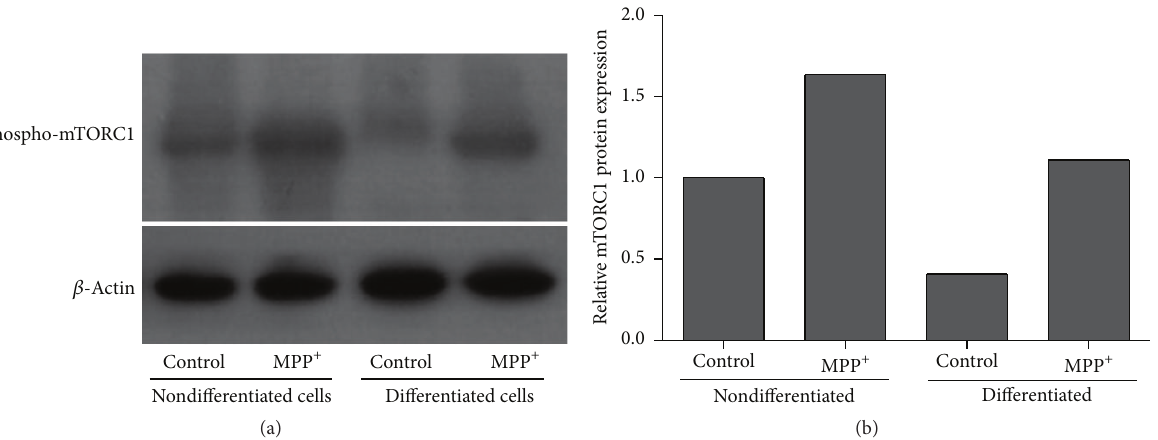
Figure 8: Relative protein expression of phospho-mTORC1 in nondifferentiated and differentiated SH-SY5Y cells by Western blot. For neuronal differentiation, SH-SY5Y cells were treated with 10 𝜇 M retinoic acid for three days before exposure to MPP + . The control groups for nondifferentiated and differentiated SH-SY5Y cells were treated with the same medium without MPP + . (b) represents the quantification of the band density normalized to actin, relative to a nondifferentiated